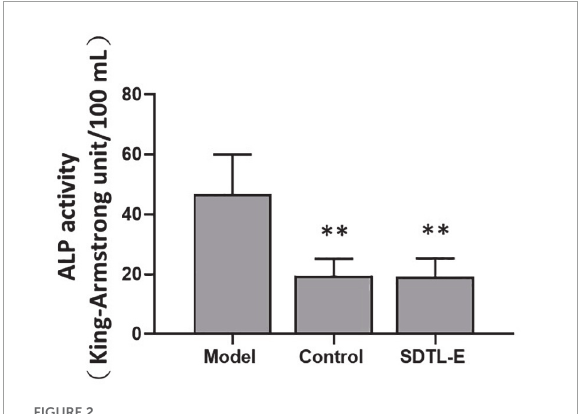
FIGURE2 SDTL-E treatment reduced serum ALP activity of OVX-induced osteoporosis rats. Model Group ( n = 11) and Control Group ( n = 10) rats were treated with vegetable oil. SDTL-E Group ( n = 10) rats were treated with SDTL-E. All treatments were topically applied twice daily for 20 days. Serum ALP activities were determined by ALP assay. Values are mean ± SD . ∗∗ p < 0.01 vs. Model